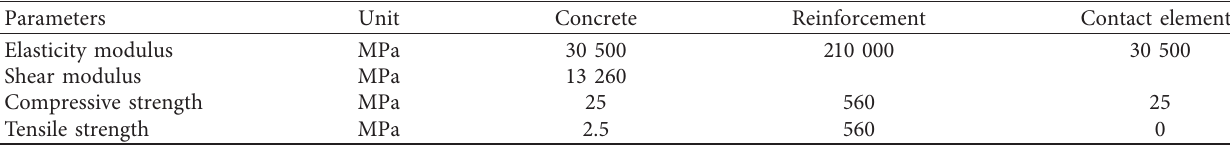
Table 4: Adopted basic material parameters for concrete, reinforcement, and contact